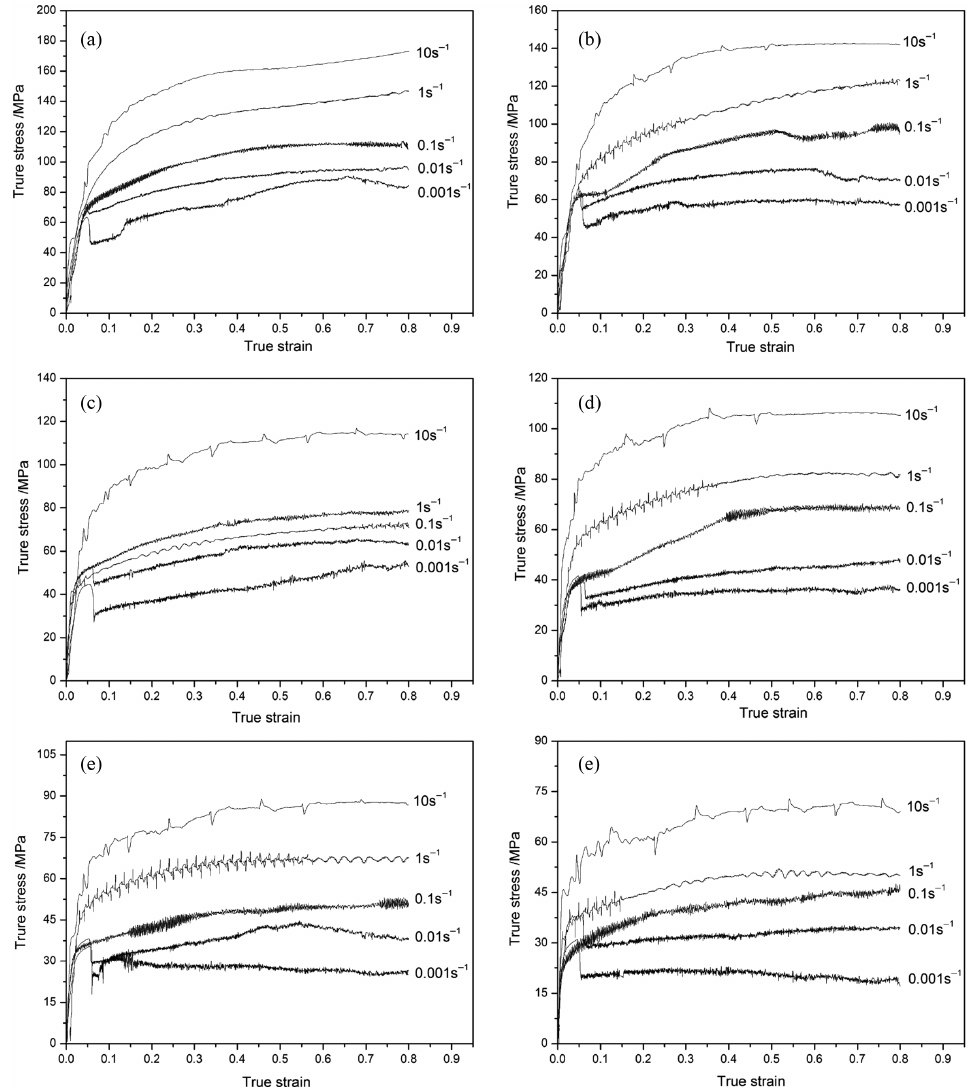
Figure 3: Flow curves of BFe10-1-2 alloy at various strain rates with temperatures of (a) 1,023 K, (b) 1,073 K (c) 1,123 K, (d) 1,173 K, (e) 1,223 K, (f) 1,273